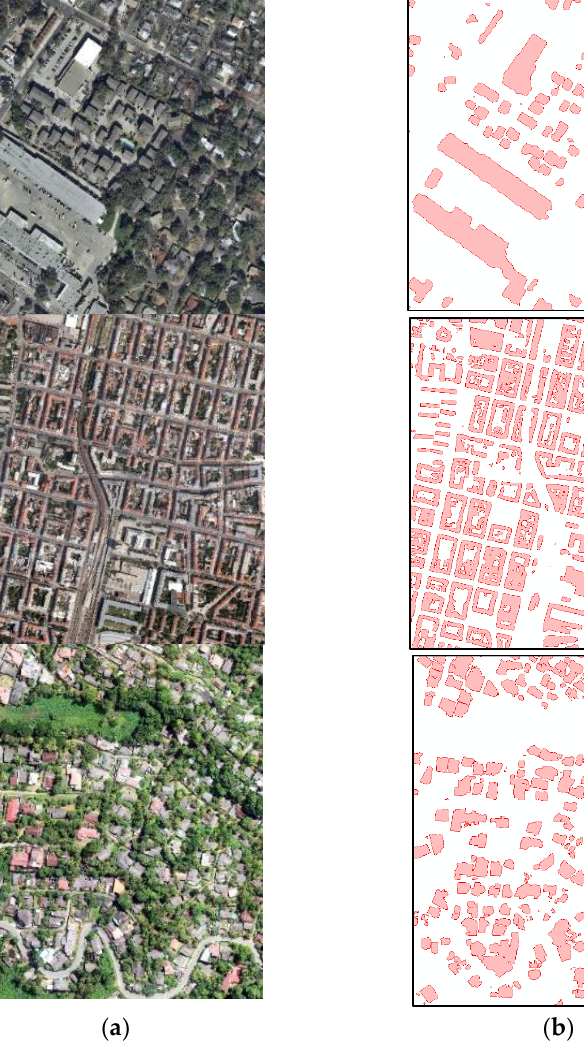
Figure 10. Initial building polygon results after being converted from the building raster masks of the model output: ( a ) RGB images; ( b ) Initial building polygons; ( c ) Building polygons overlayed on images.